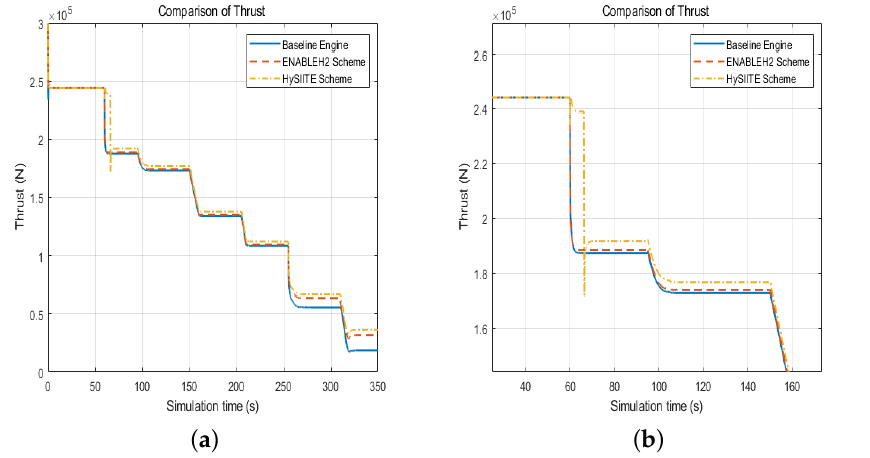
Figure 7. Thrust comparison of baseline engine, ENABLEH2 scheme, and HySIITE scheme: ( a ) thrust curve under full flight envelope; ( b ) local thrust